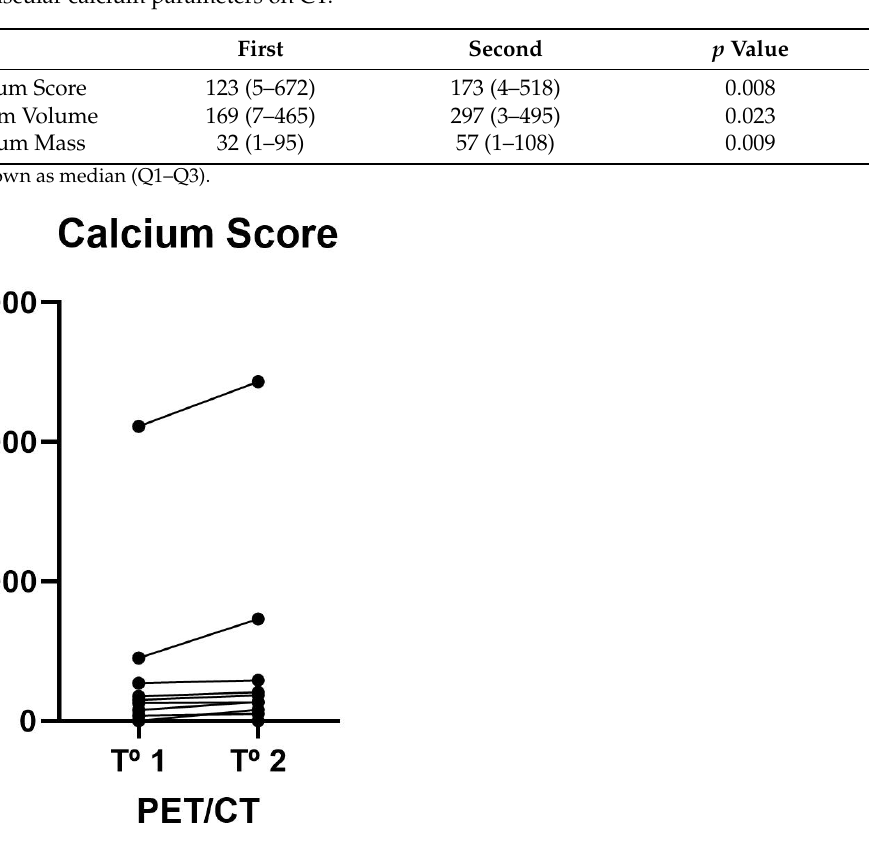
Table 1. Vascular calcium parameters on CT.